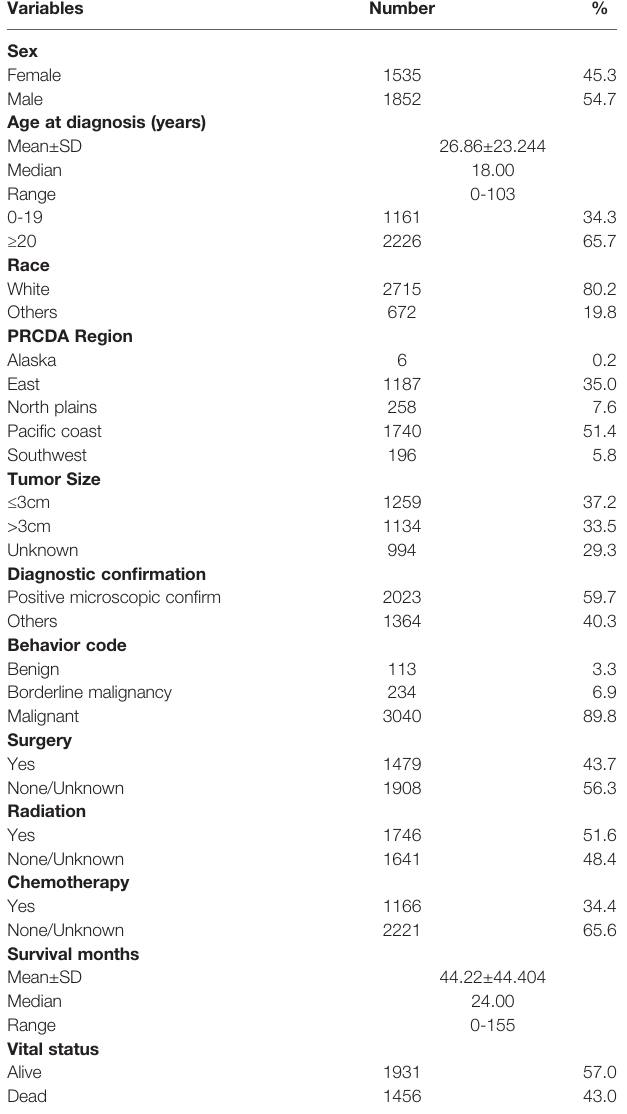
TABLE 1 | Demographic and clinical characteristics of patients with brainstem